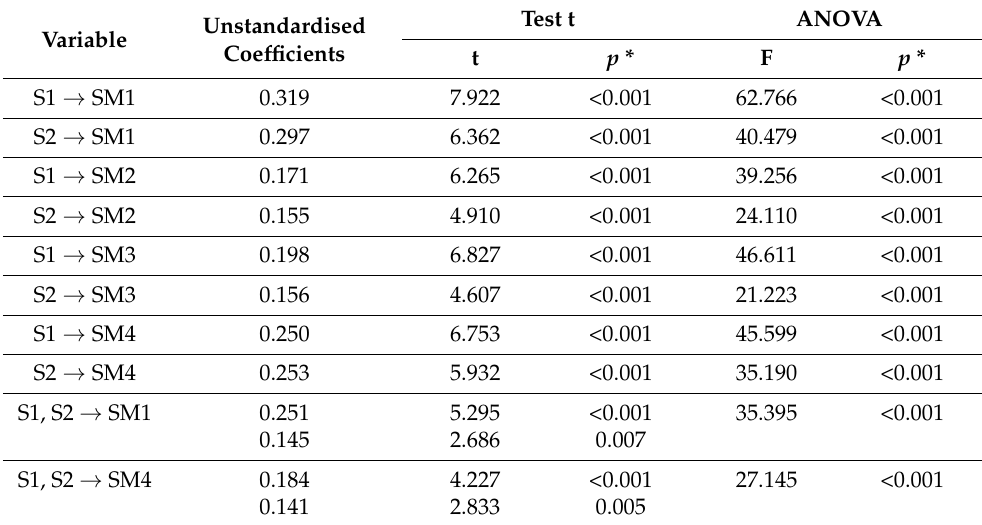
Table 6. Sustainability vs. Smart Mobility—linear regression results. Variable